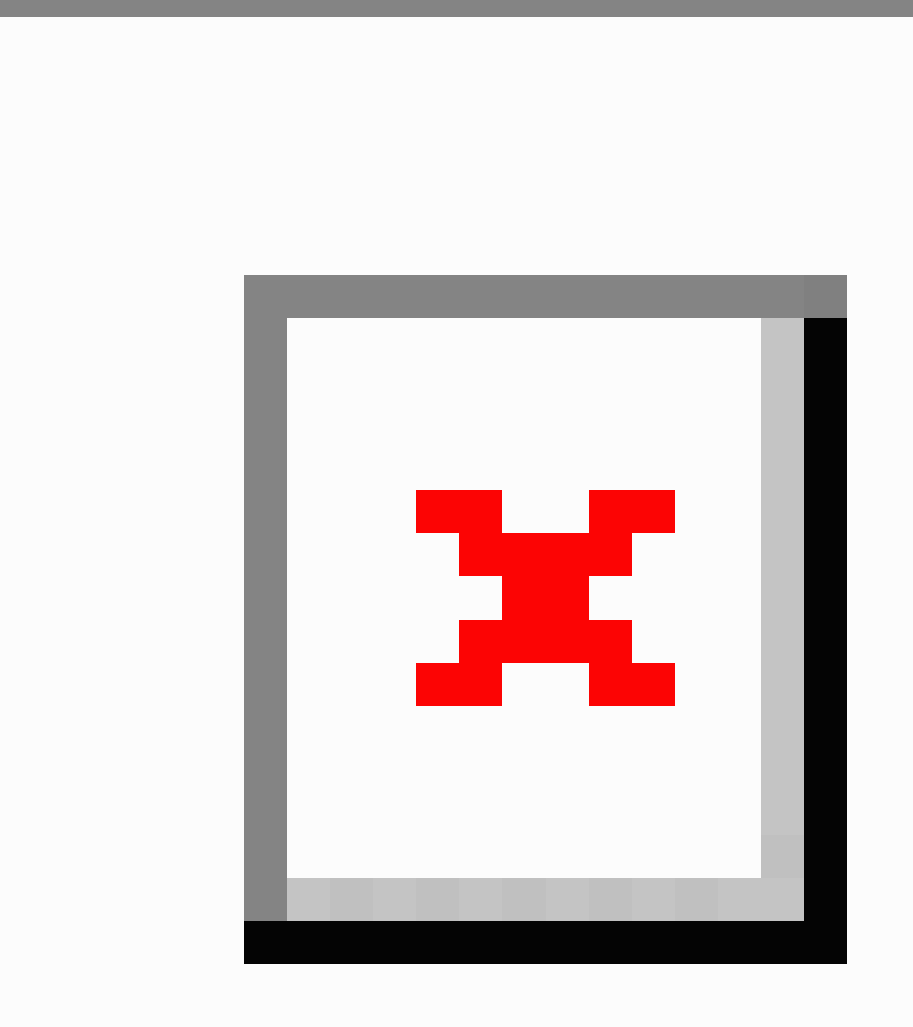
Figure 2. The Adolescents’Digital Technology Interactions and Importance